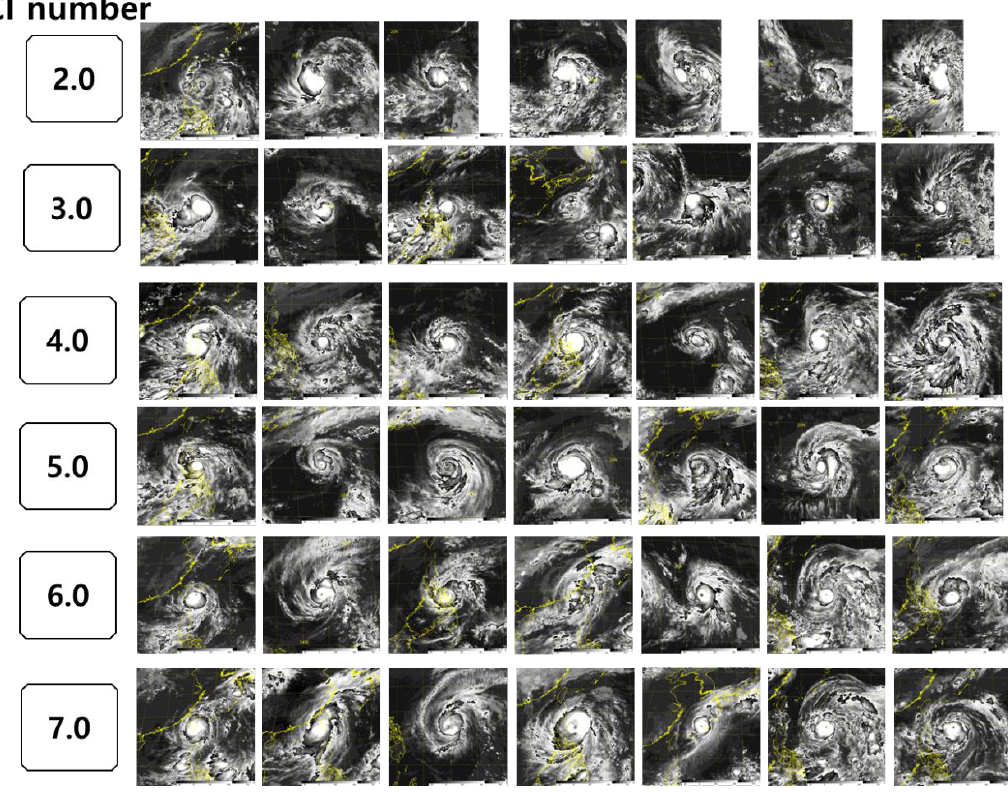
Figure 4. Examples of current intensity (CI) number and the corresponding enhanced Infrared (EIR) images from the COMS